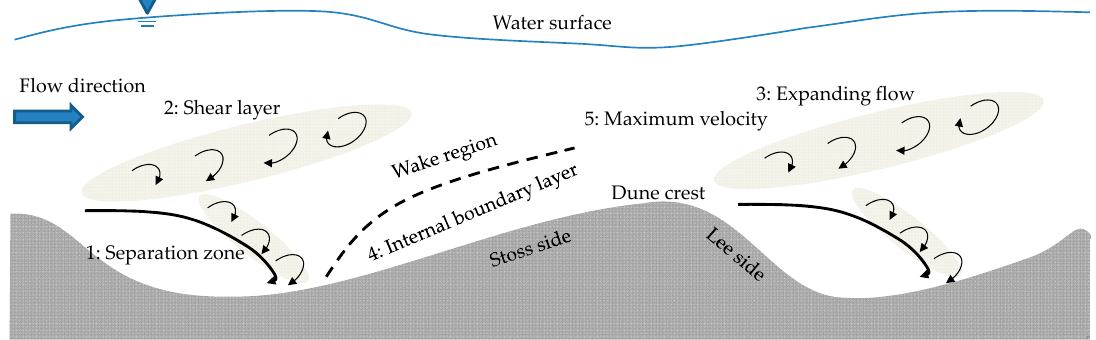
Figure 1. Schematic diagram of principal regions of flow over the dunes [15,17].